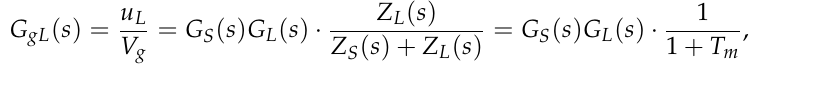
Figure 6. Inter connection of the sub-system for the MVDC distribution system.